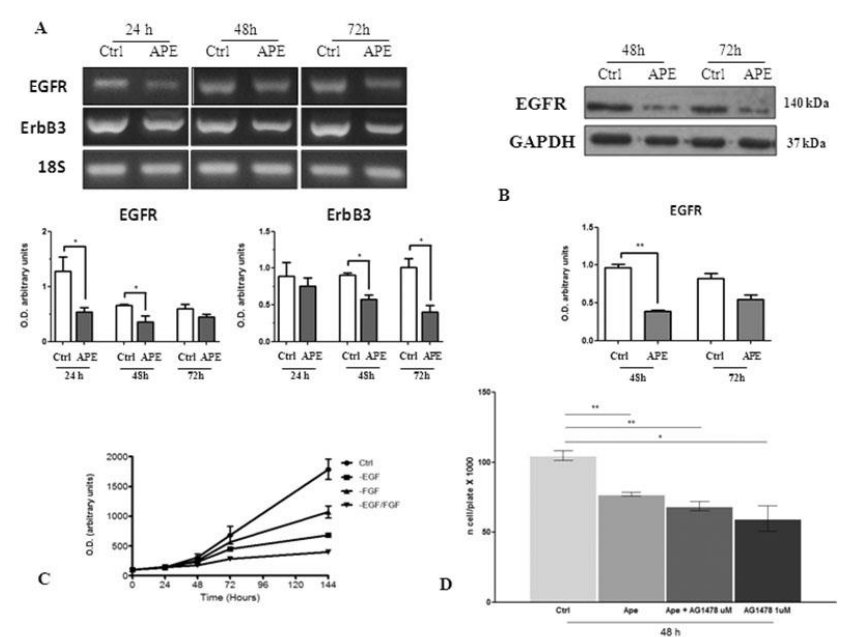
Figure 11. ( A ) RT-PCR analysis of EGFR and ErbB3 receptors in GB7 cells. 18 S was used as a housekeeping gene. The graphs below show the densitometric analysis of the bands of RT-PCR indicated in Fig. A normalized with the bands of housekeeping gene 18 S. The data are the average ± SEM of three independent experiments (* p < 0.05 t-test). ( B ) EGFR expression by Western blot analysis on GB7 cells. GAPDH was used as an internal reference protein. The graph below shows the densitometric analysis of the bands of Western blot analysis for EGFR normalized with the bands of the reference protein GAPDH. The data are the average ± SEM of three independent experiments (** p < 0.01 t-test). ( C ) MTT assay performed on GB7 cells maintained in complete culture medium containing EGF and FGF (ctrl) either in the absence of FGF, or of EGF, or in absence of both growth factors. ( D ) MTT assay performed after 48 h of treatment with 100 µ M APE or 1 µ M of TKI AG1478 inhibitor (t-test; * p < 0.05; ** p < 0.01). The data are the average ± SEM of three independent experiments performed in triplicate.